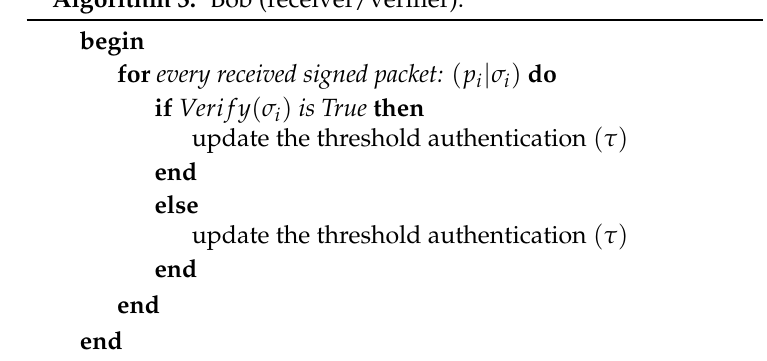
Algorithm 3: Bob